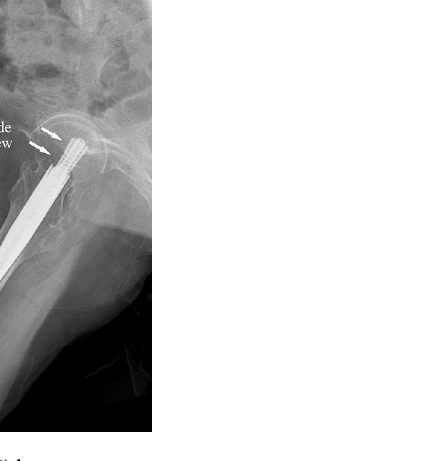
Figure 1. Standard lag screw and U-blade (RC) lag